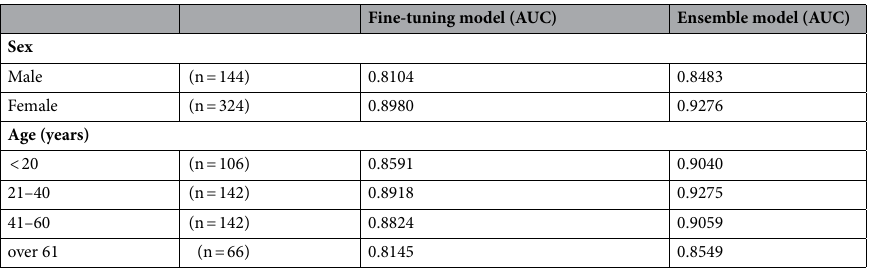
Table 2. Detailed prediction results (AUCs) of test data sets according to sex and age groups. The ensemble model shows improved AUCs compared to one fine-tuning model. The AUC is substantially higher in women than in men. The AUCs do not differ significantly for ages 11 (minimum)–60 years, while the AUC for age > 61 years is decreased. AUC area under the